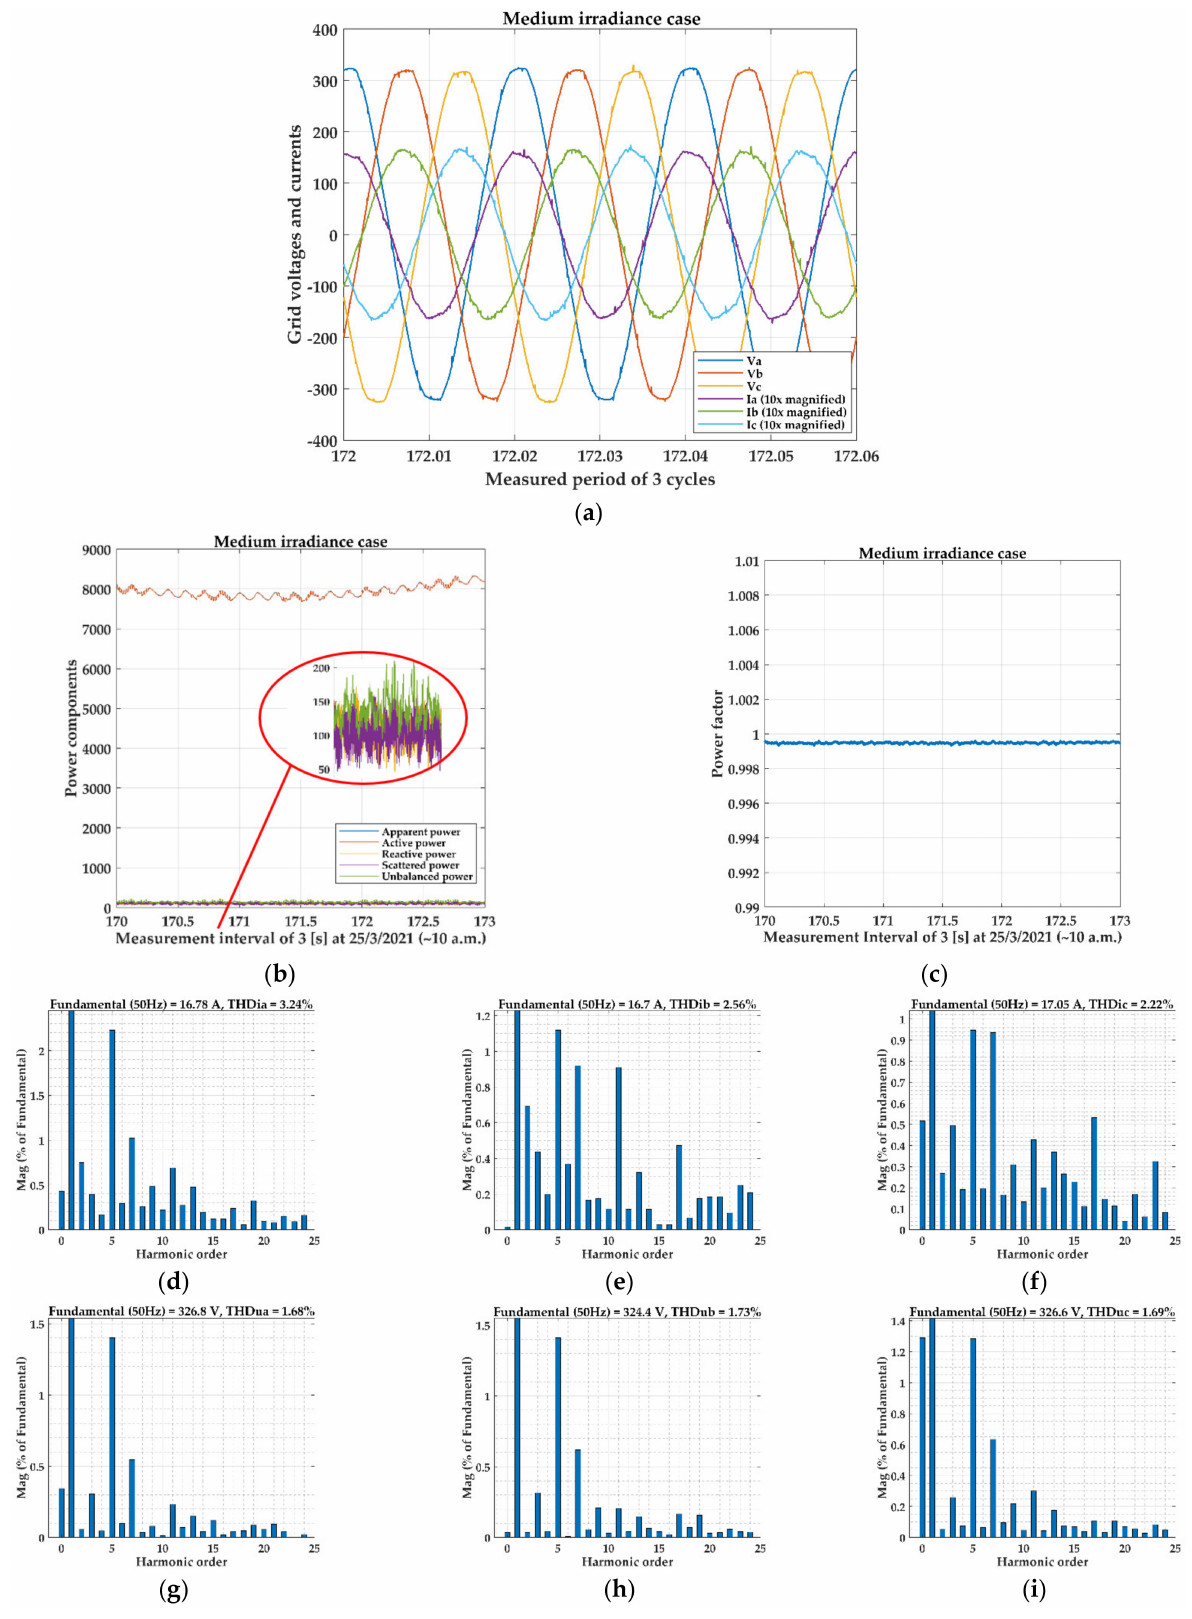
Figure 9. Experimental results for the medium irradiance case: ( a ) Grid voltage and current wave- forms; ( b ) power components according to CPC theory; ( c ) power factor; ( d – f ) harmonic spectra and THD I factors of inverter currents; ( g – i ) harmonic spectra and THD U factors of grid